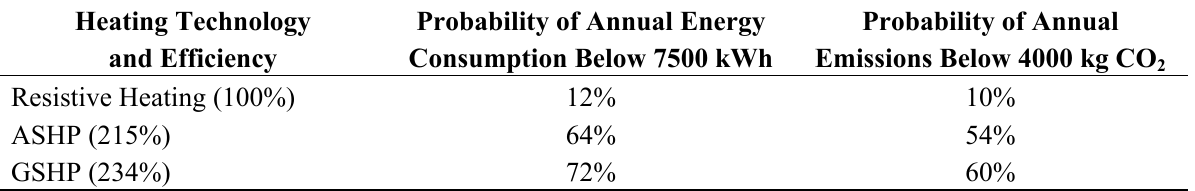
Table 8. Probability of heat pump energy consumption and CO that of resistive heating